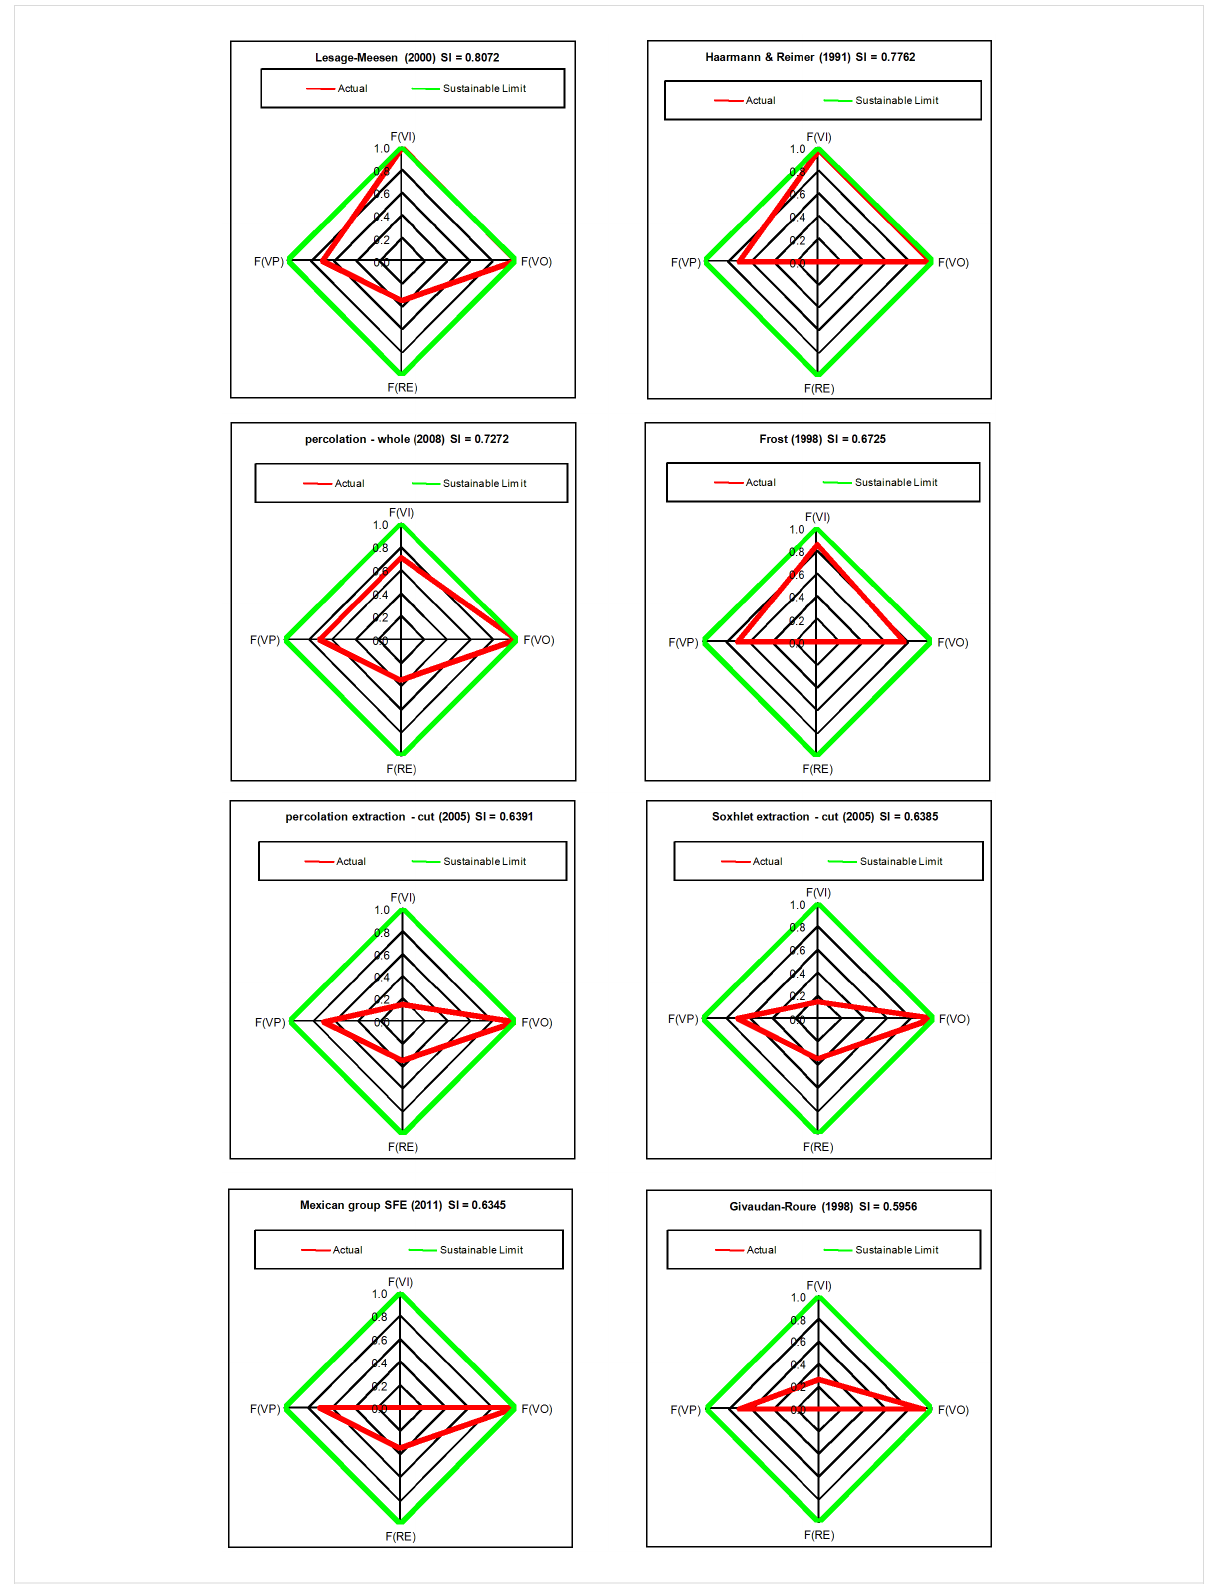
Figure 1: Radial diamond diagrams illustrating the sustainability index (SI) computed based on F VI , F VO , F VP , and F RE for the top eight scoring vanillin synthesis